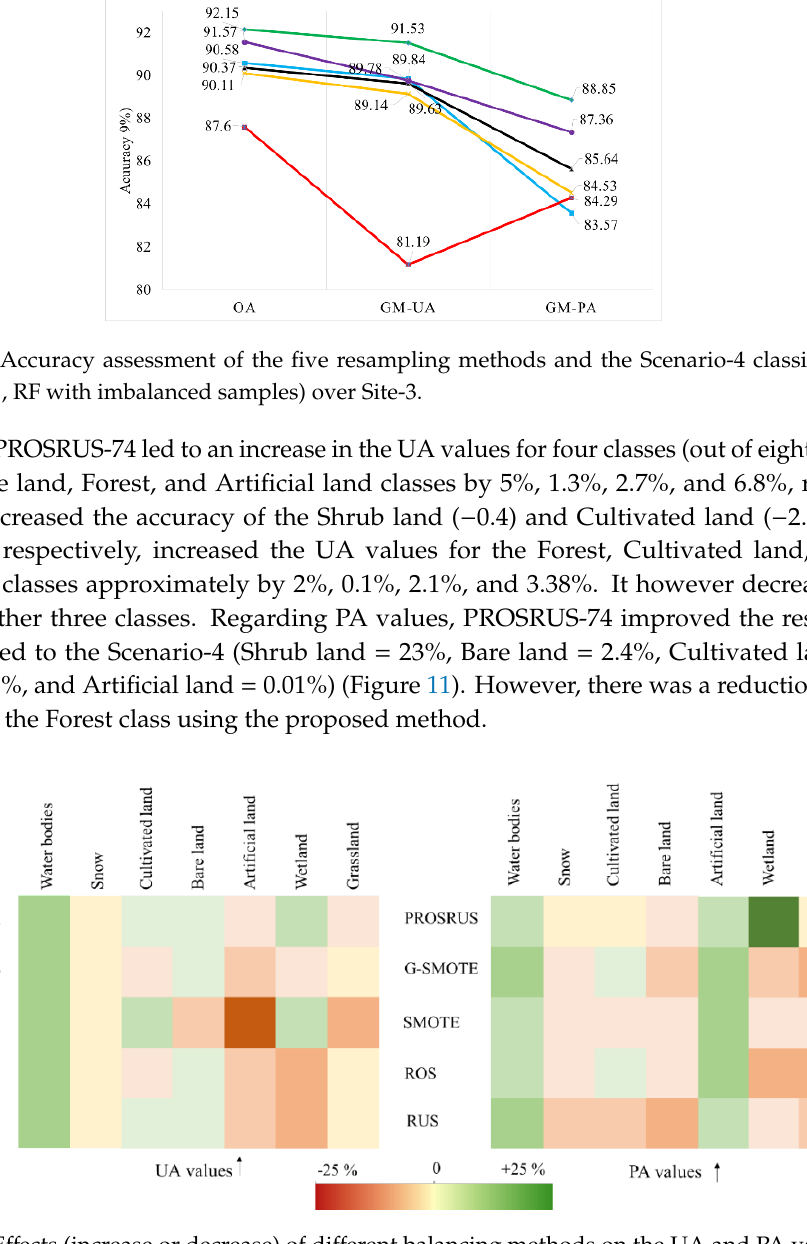
Figure 9. Effects (increase or decrease) of different balancing methods on the UA and PA values of various classes in Site-2. Refer to Appendix D for more information